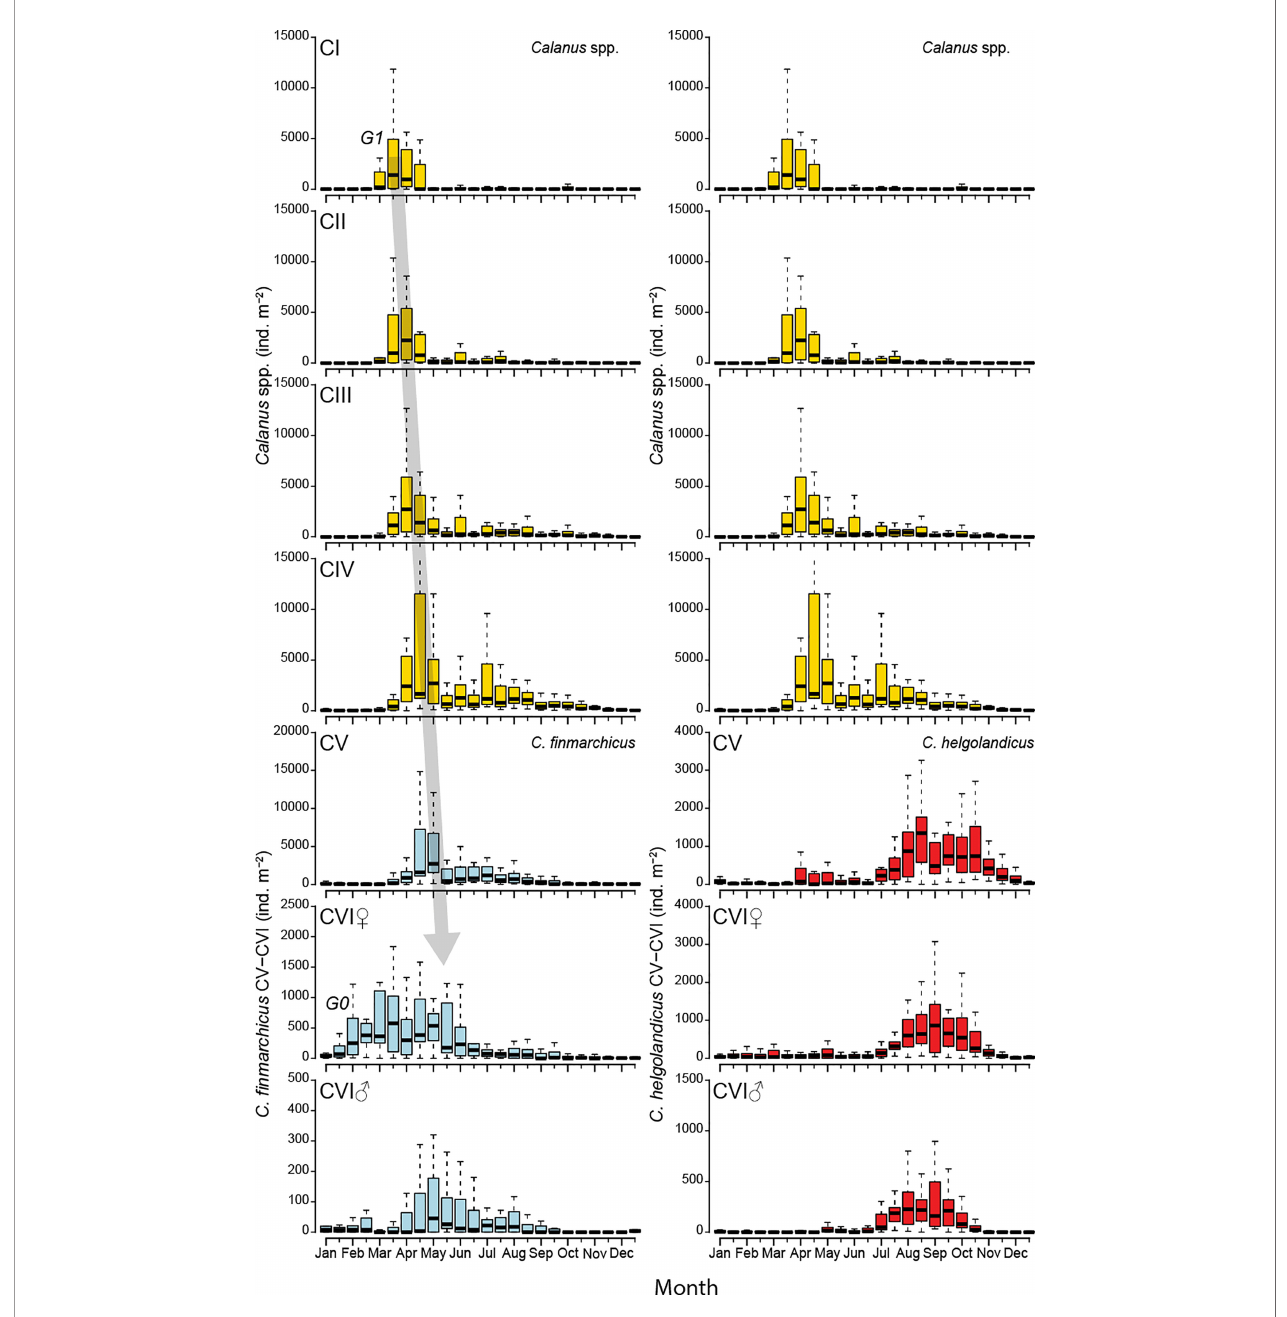
FIGURE 4 | Boxplots of abundances of Calanus spp CI-IV (yellow), C. fi nmarchicus CV-VI (blue) and C. helgolandicus CV-VI (red) versus two-week period. Lower and upper edges of boxes represent the 25 and 75 percentiles, and the horizontal lines the medians. Extreme observations outside the range of the whiskers are not shown. Copepodite stages CI-IV were not identi fi ed to species but are included in both left- and right-hand panels to aid elucidation of stage and generation cycles for each species. The shadowed arrow indicates our suggested fi rst new generation of C. fi nmarchicus of the year, G1; G0, overwintering